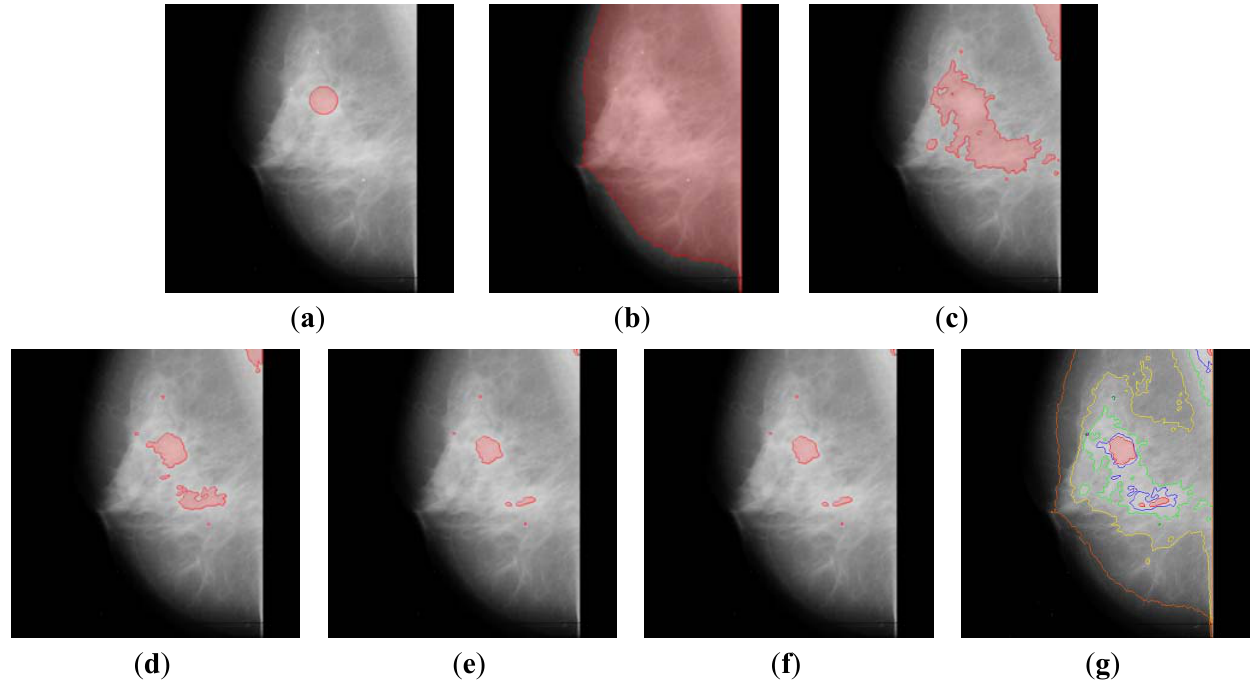
Figure 5. The mini-MIAS database of mammogram number 063 ( a ) The approximated region of abnormality from the database. ( b ) Contour 1 after 8 iterations of (14). ( c ) Contour 2 after 12 iterations. ( d ) Contour 3 after 9 iterations. ( e ) Contour 4 after 11 iterations. ( f ) Last contour 5 after 12 iterations. ( g ) Final contour map.